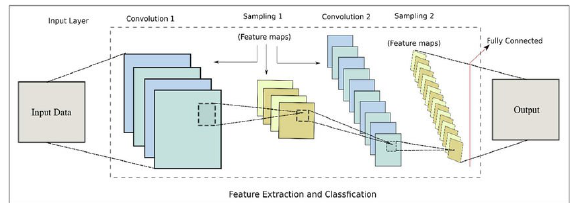
Figure 3.2: CNN Architecture